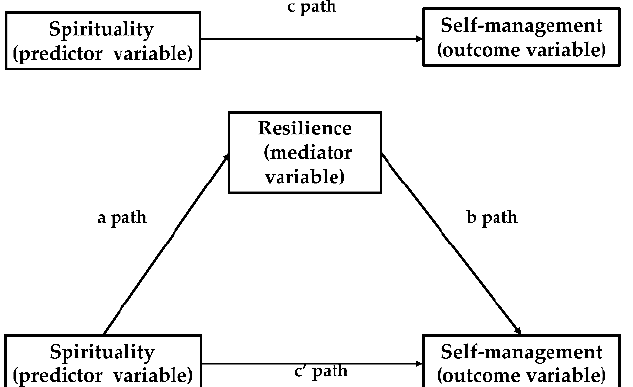
Figure 1. Diagram of paths in the mediation